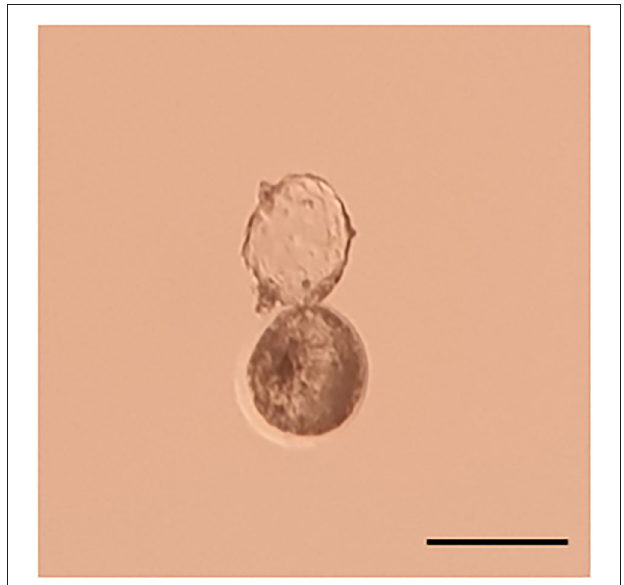
FIGURE 1 | Photograph of the blastocyst transferred to the recipient. The blastocyst was 6 days old and started to hatch through the zona pellocida. The bar is 250